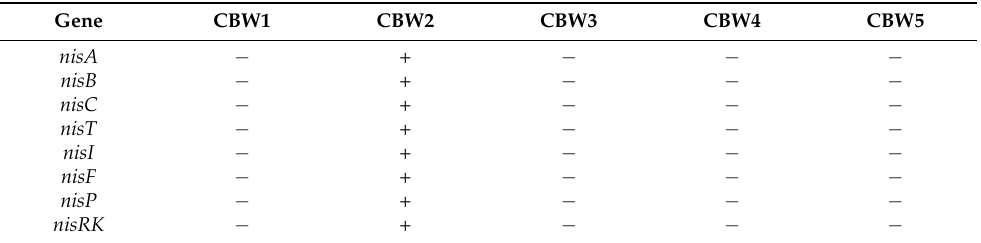
Table 7. PCR results for nisin biosynthesis-related genes in five Lactococcus lactis subsp. lactis strains isolated from the fecal sample of a stranded female Cuvier’s beaked whale a